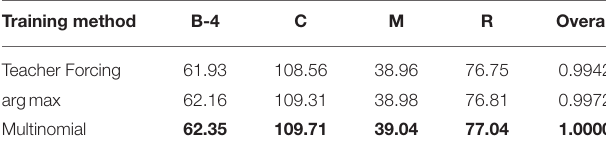
TABLE 5 | Results of different training strategies on YouTube2Text data with the best semantic features.